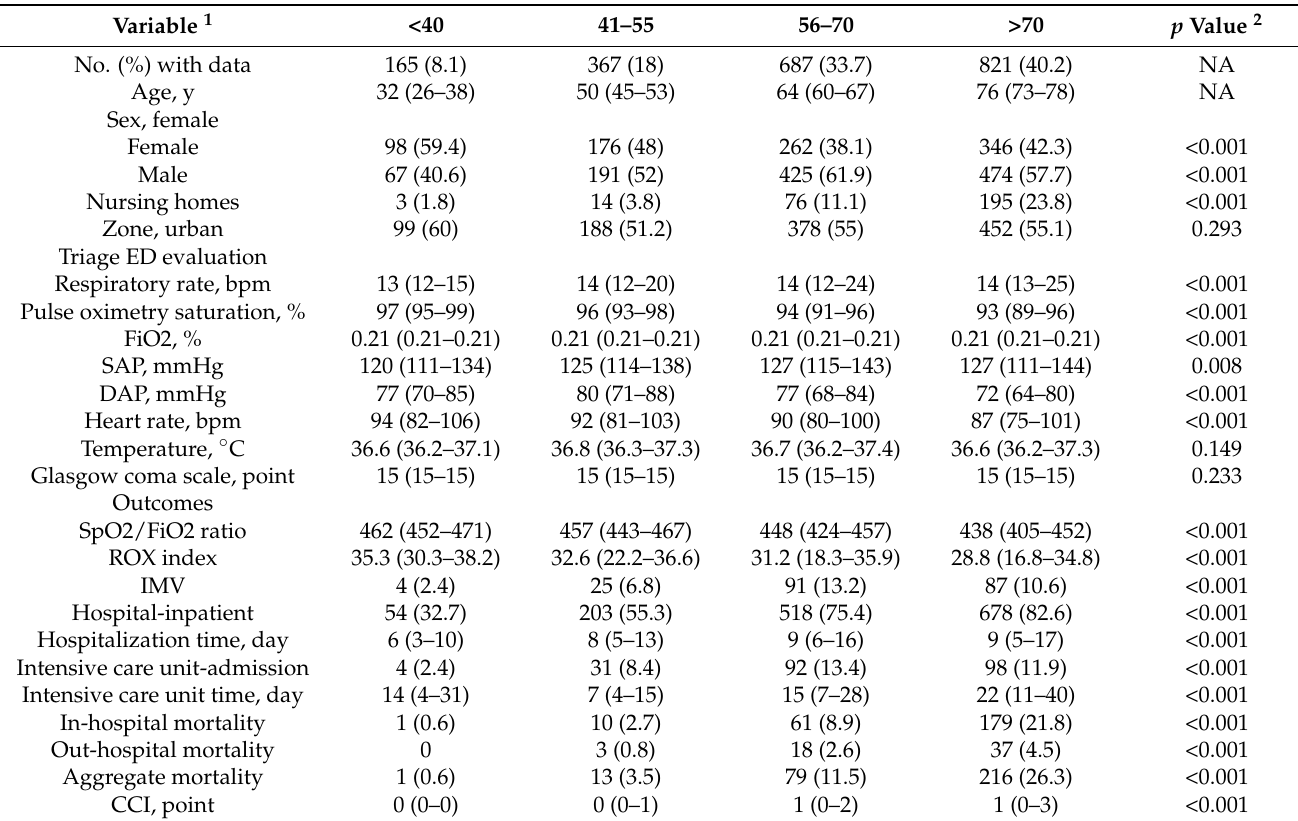
Table 2. Population distribution based by age categories under